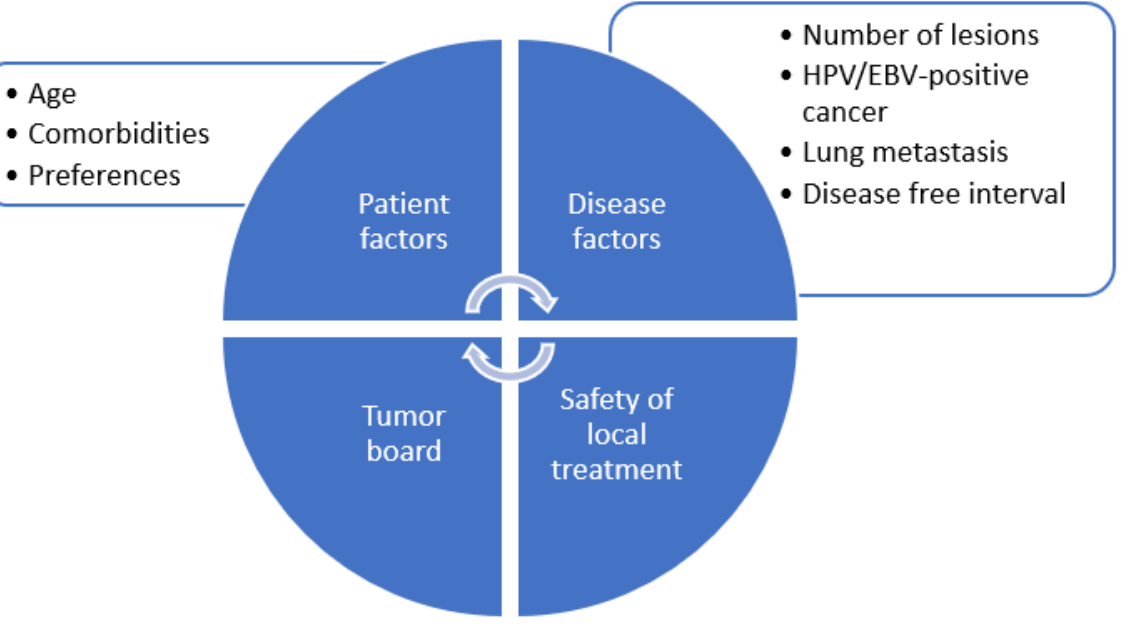
Figure 2. Approach to patient selection for radical treatment in metastatic head and neck cancer.